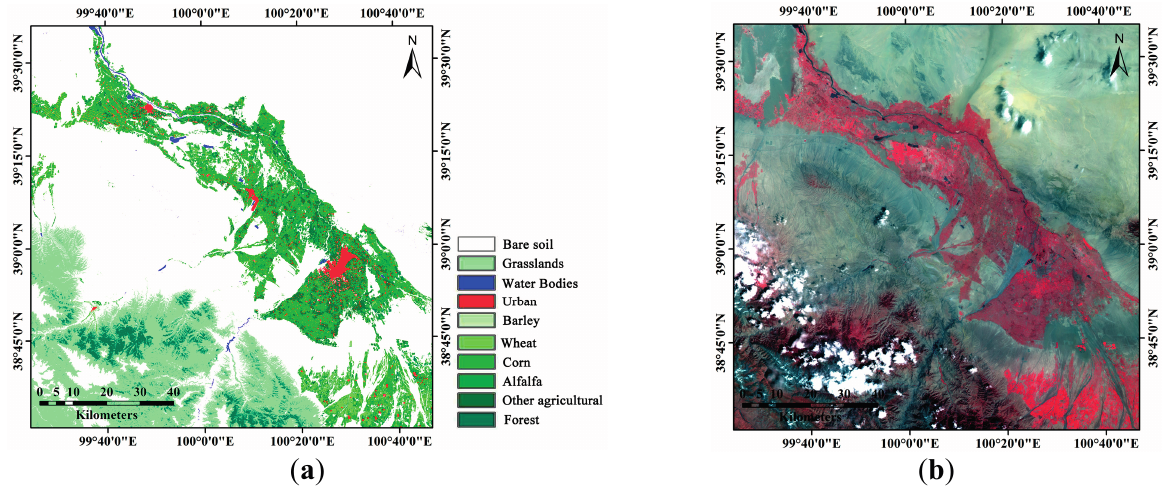
Figure 2. ( a ) Land cover map of the study area in the middle reach of the Heihe River Basin in July 2013. The major vegetation types are corn (green), grassland (light green), forest (dark green) and urban lands (red). ( b ) False color composite of HJ1/CCD image for the study area on 3 June 2013.